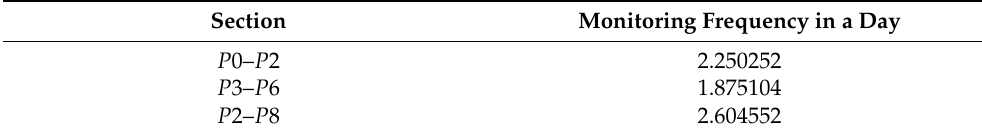
Table 6. Monitoring frequency in a day for the configurations P 0– P 2, P 3– P 6 and P 2– P